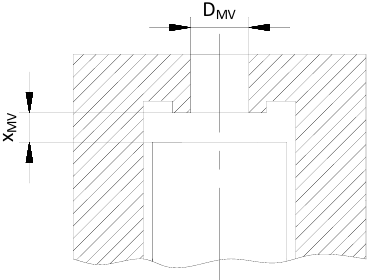
Figure 2. Solenoid valve cross section